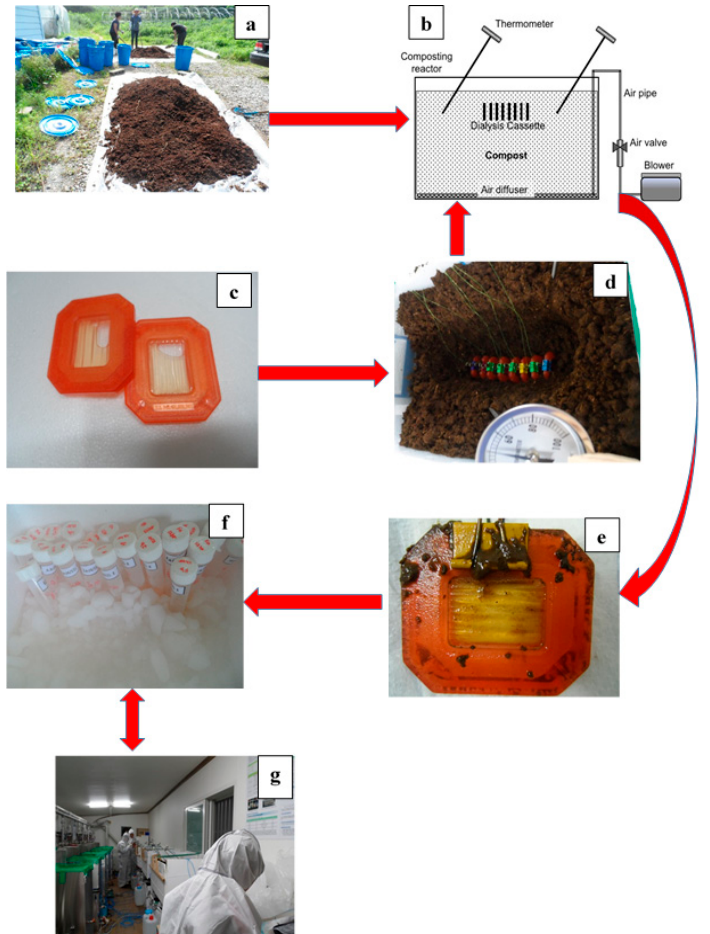
Figure 1. Flow diagram showing the processes involved in experimental set-up and sample collection in our study. ( a ) compost preparation. ( b ) Schematic diagram of composting reactor. ( c ) Cassette before burial in the compost. ( d ) Dialysis cassettes containing virus (H9N2, EMCV) buried in compost. ( e ) Cassette recovered from the compost. ( f ) Virus samples collected from dialysis cassettes recovered from compost pile. ( g ) Laboratory for composting